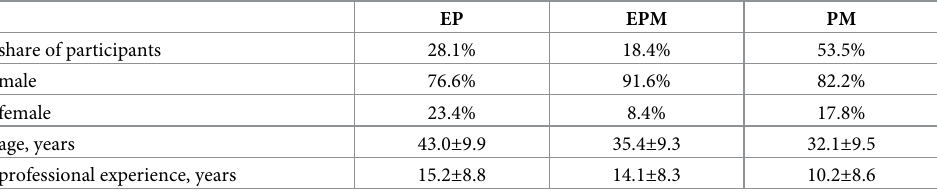
Table 1. Participants.